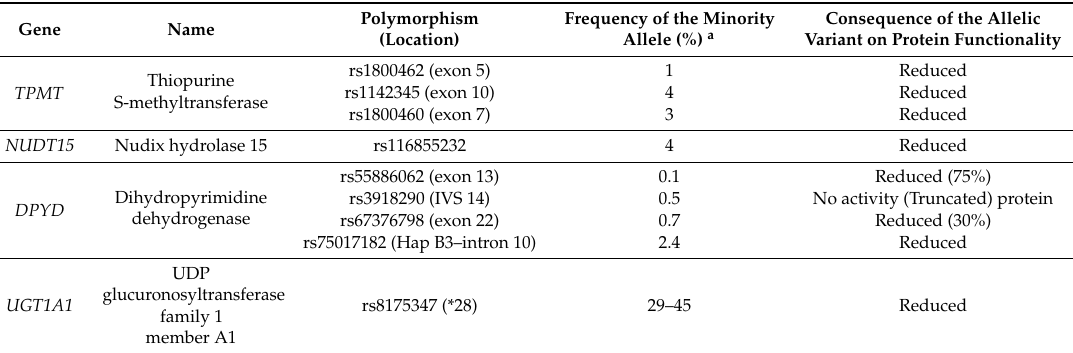
Table 1. Genetic variants of interest included in the multiplex